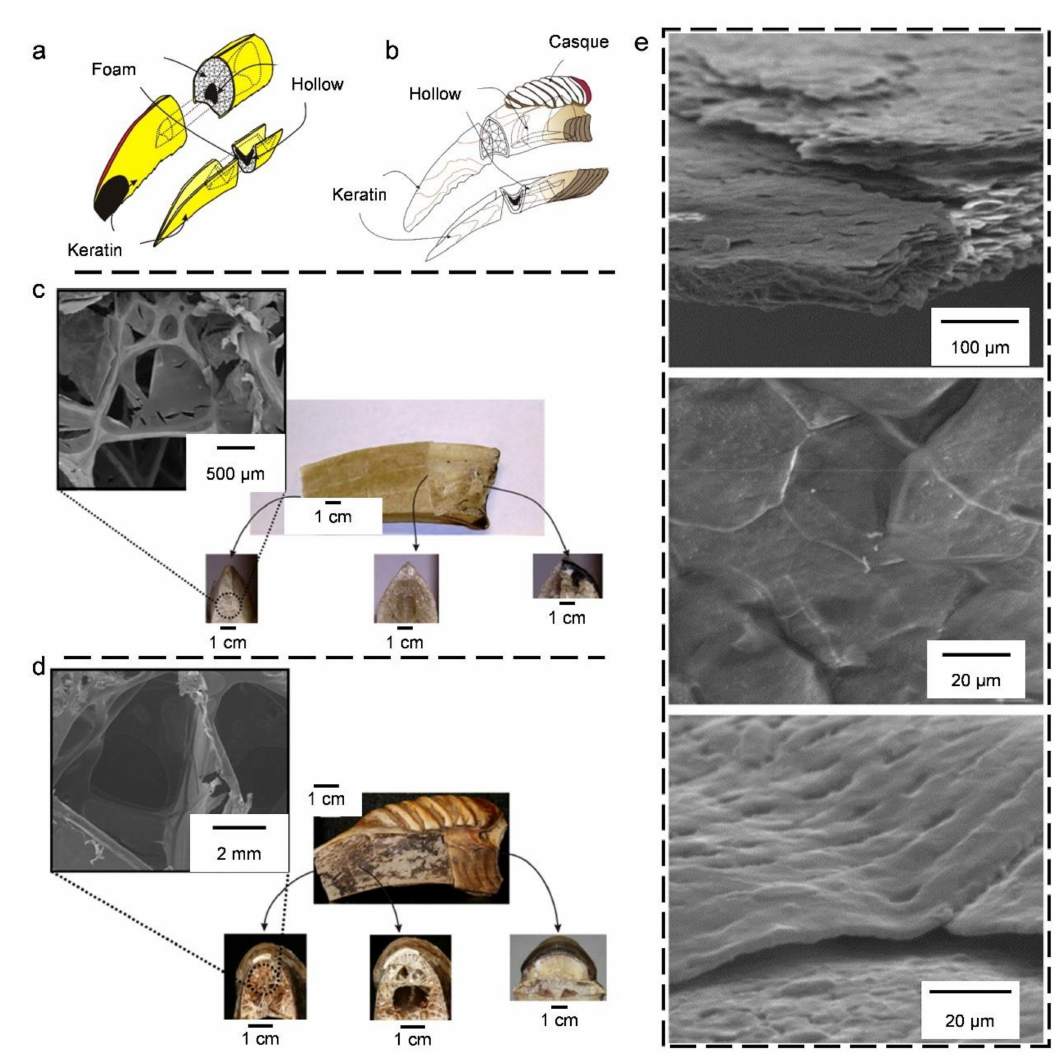
Figure 7. ( a , b ) Schematics of the toucan beak and hornbill beak. Reprinted with permission from [11], copyright 2008 Elsevier. ( c , d ) Micro-images of the internal foam structures with three different cross-sections of toucan beak and hornbill beak. Reprinted with permission from [11], copyright 2008 Elsevier. ( e ) SEM images of the exterior of the beak (keratin) from different views. Reprinted with permission from [39], copyright 2005 PERGAMON-ELSEVIER SCIENCE